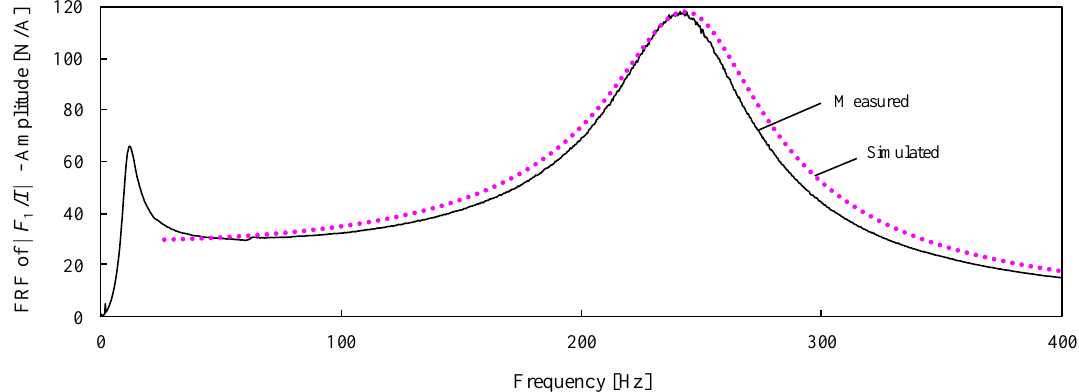
Figure 8. Simulation validation of the active FRF of | F 1 / I | at 25–400 Hz for the fluid-filled state . Key : Measured ( ––– ); Simulated ( ····· ).